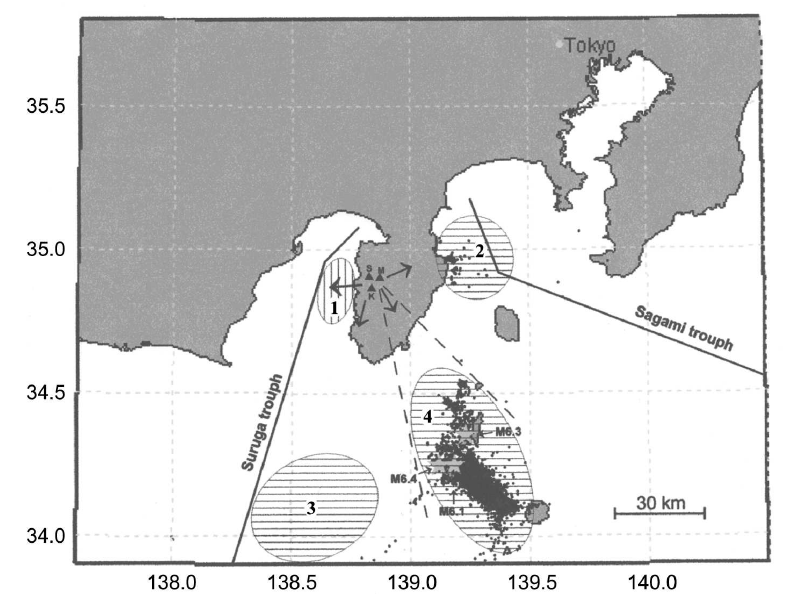
Figure 7. Direction finding results. Different azimuthal directions in Fig. 6, correspond to different noise sources (numbered 1-4 in Fig. 6).